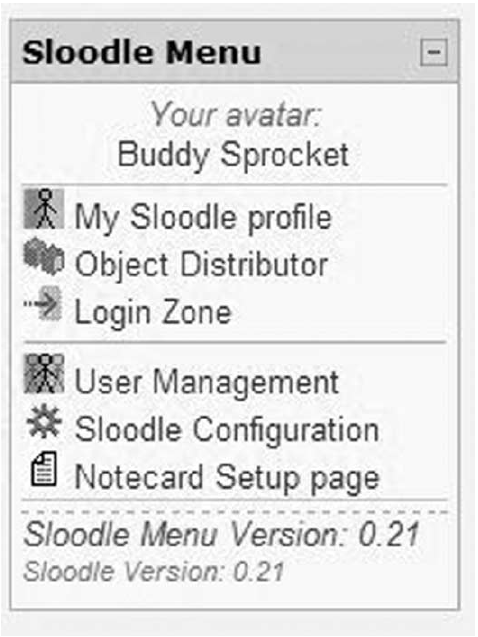
Figure 5. Sloodle menu block. A number of administrative features are available via Moodle – in- cluding the ability to send items to avatars inside Second Life without having to log in to the 3D en-